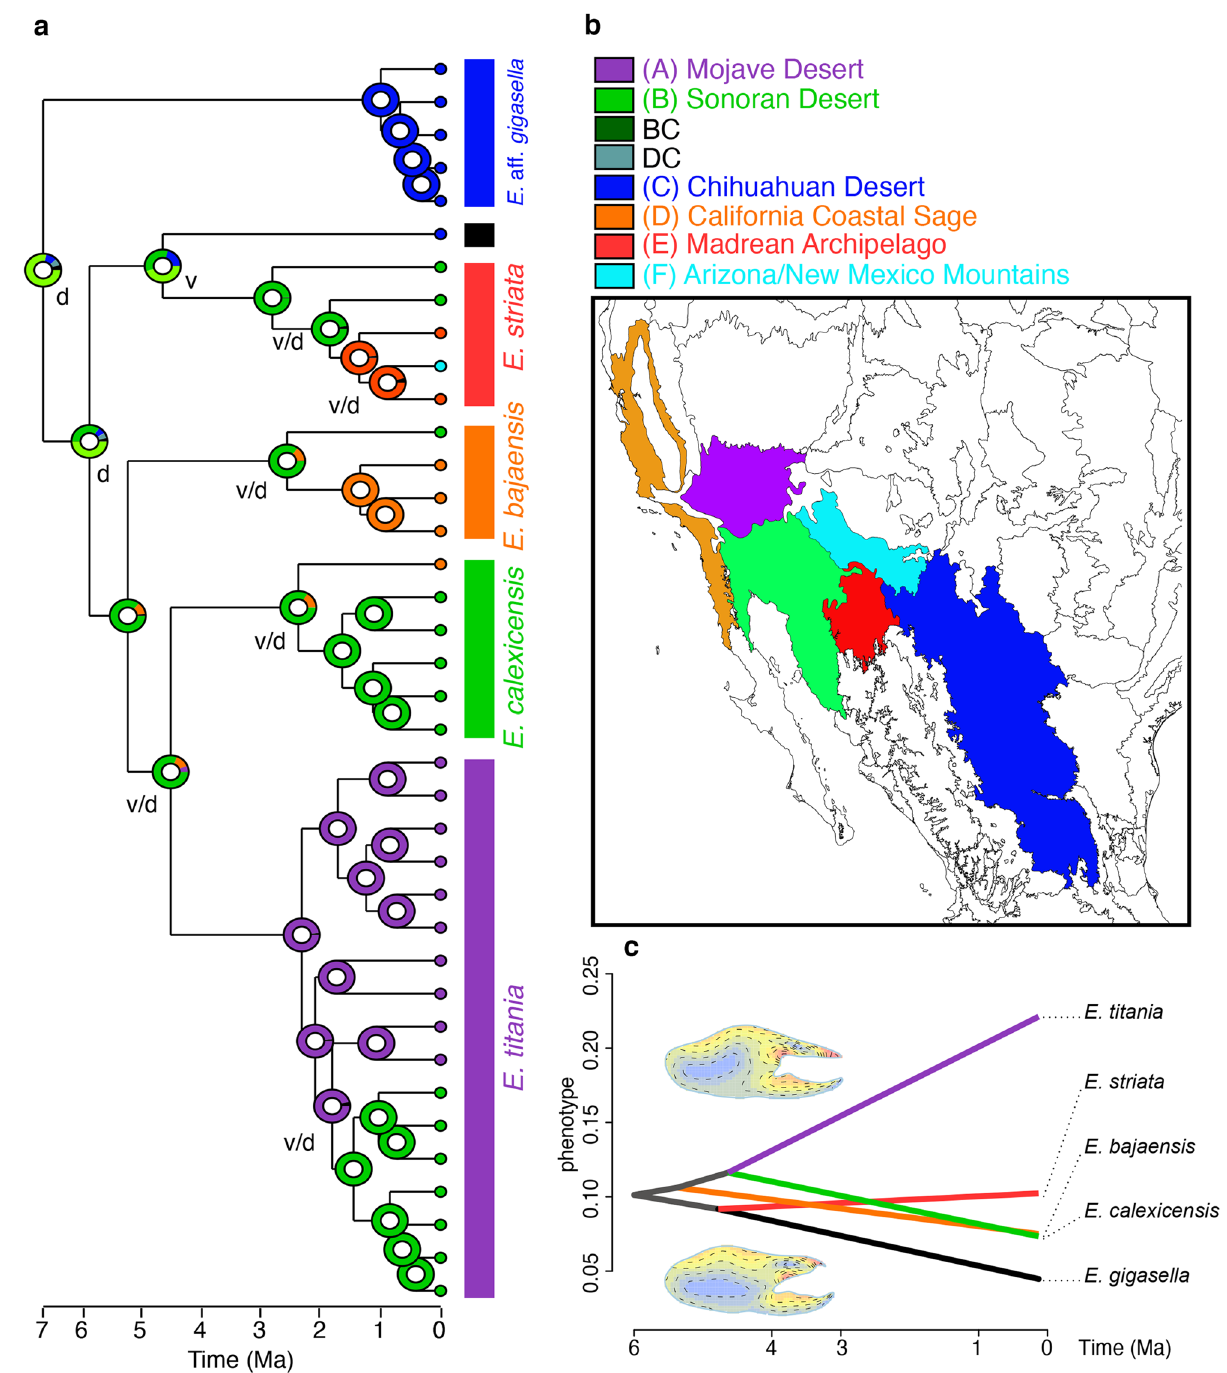
Figure 2. Historical biogeography of the camel spider genus Eremocosta . Ancestral areas estimated by RASP using DEC + j were mapped on MRCA nodes for each species in our favored time-calibrated topology ( a ) and onto the ecoregions map of North America ( b ). The colors of each circle indicate the proportion of support for each biogeographical area received for that node. Dispersal = d, vicariance = v and both = v/d events were indicated on each node. ( c ) Visualization of the Euclidean distances as a measure of the variation of morphology in the sexual dimorphism of male and female chelicerae (dextral surface) onto our dated molecular tree; x-axis indicates the time of divergence; y-axis indicates the Euclidean distance. Superimposed chelicerae (as drawn by momocs ) showing the heat map on most important changes between both sexes: delimited chelicerae represent the one from male, whereas the colored represents the female (top); or delimited chelicerae represents the one from female and the colored represents the male (bottom). * = E. gigasella . Ecoregion map was generated in ArcGIS using a base map (Ecoregion level III) from the United States Environmental Protection Agency (EPA) (available at: http:// epa. gov/ eco- resea rch/ ecore gions- north- ameri